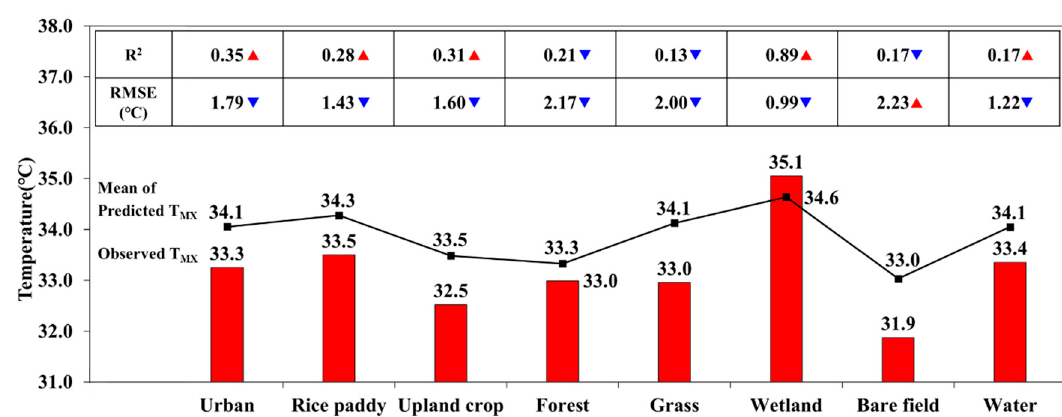
Figure 10. Comparison of mean observed T MX (red bar) and mean predicted T MX (solid line) on July 30 to August 11 for each land use classes. The triangle next to the upper statistical indicators (R 2 : coefficient of determination; RMSE: Root Mean Square Error) shows the increase (red) and decrease (blue) compared to the result of T MX prediction on heat wave period in 2018.